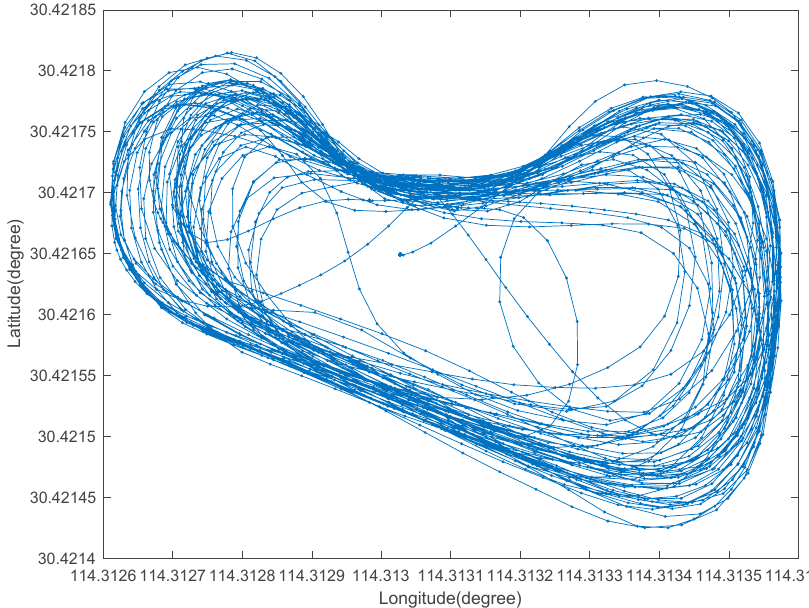
Figure 6. Driving route of moving vehicle in Wuhan, China on 14 November 2013.